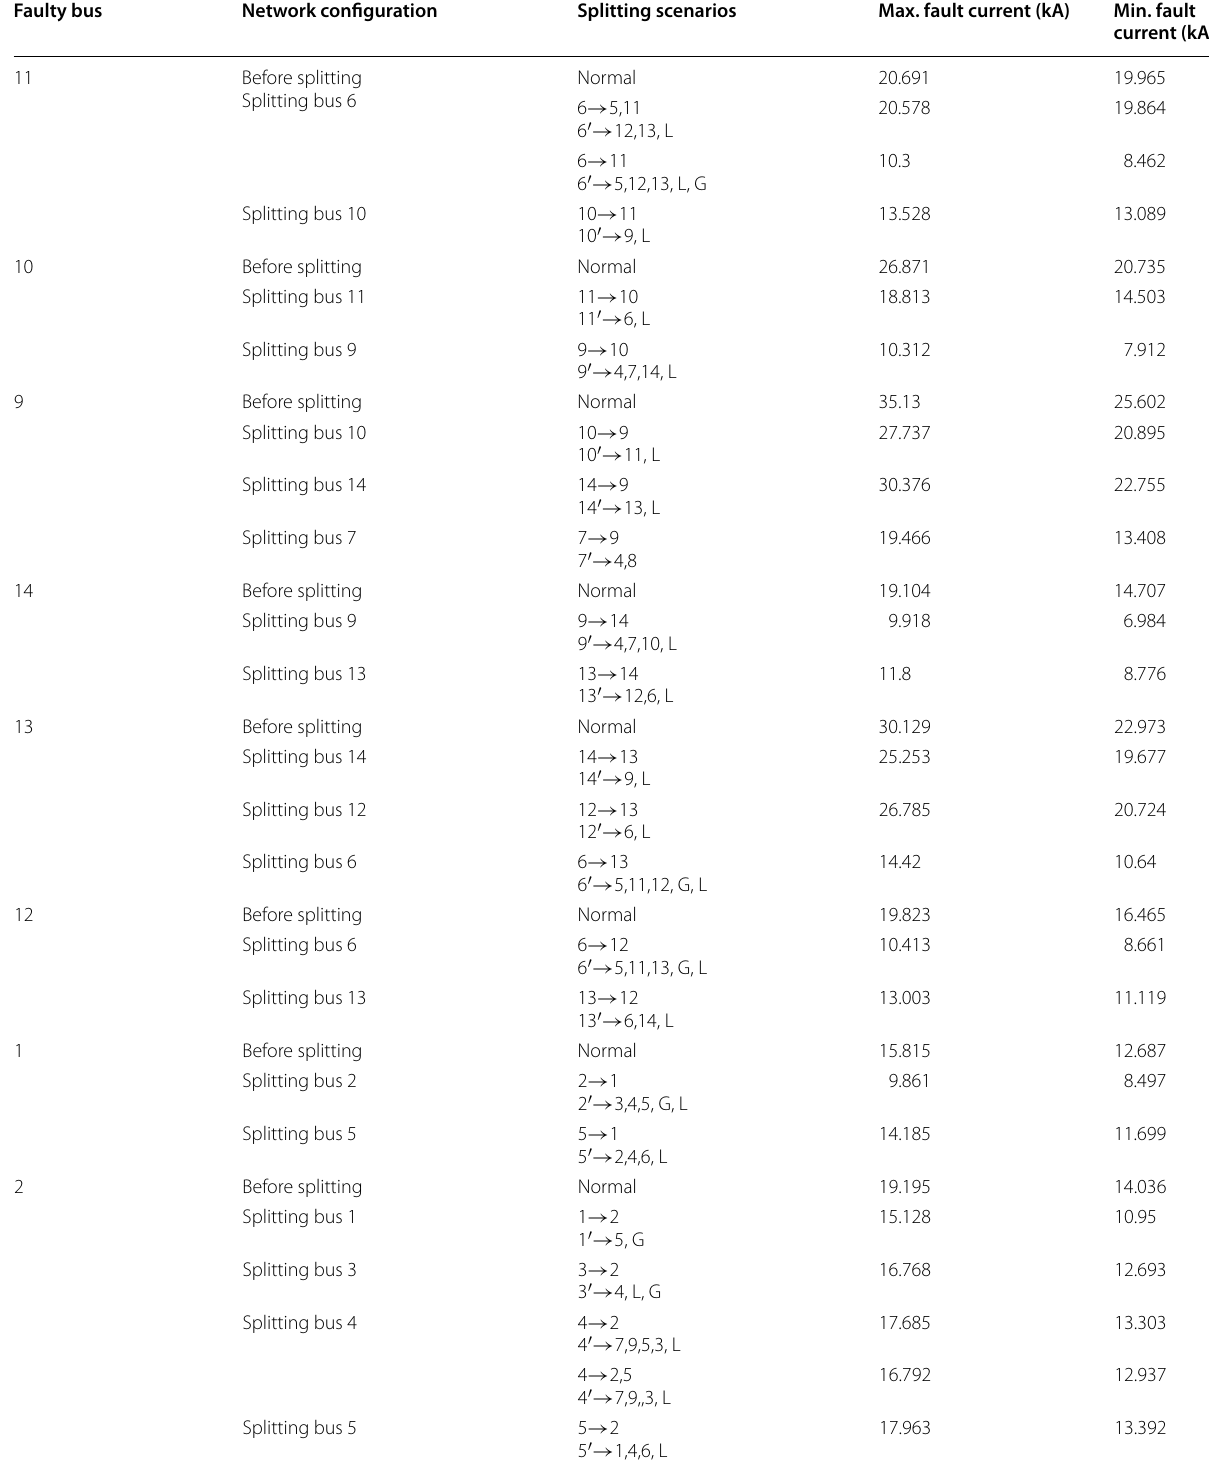
Table 2 Maximum and minimum fault currents under different splitting scenarios for varying fault conditions in the IEEE 14-bus system Faulty